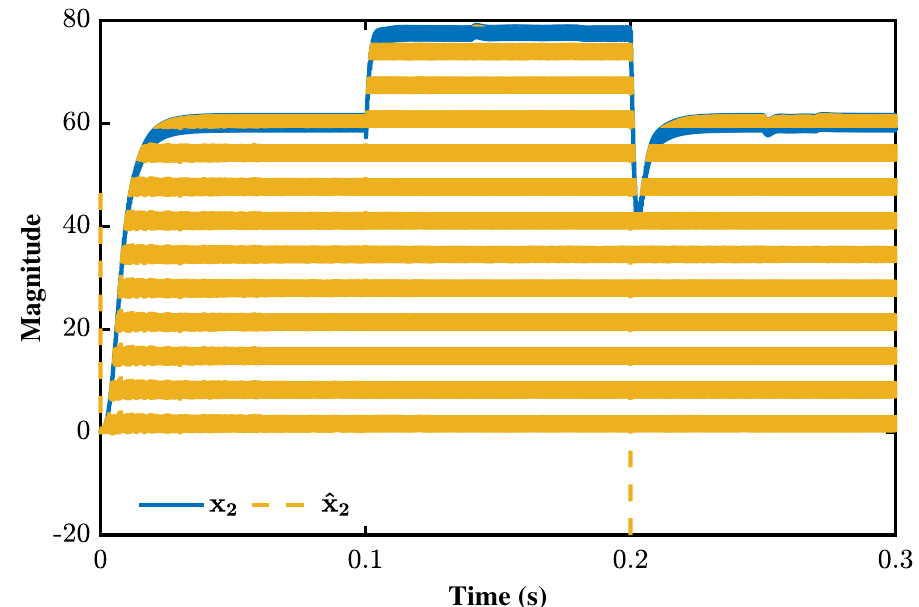
Figure 15. Estimated state by